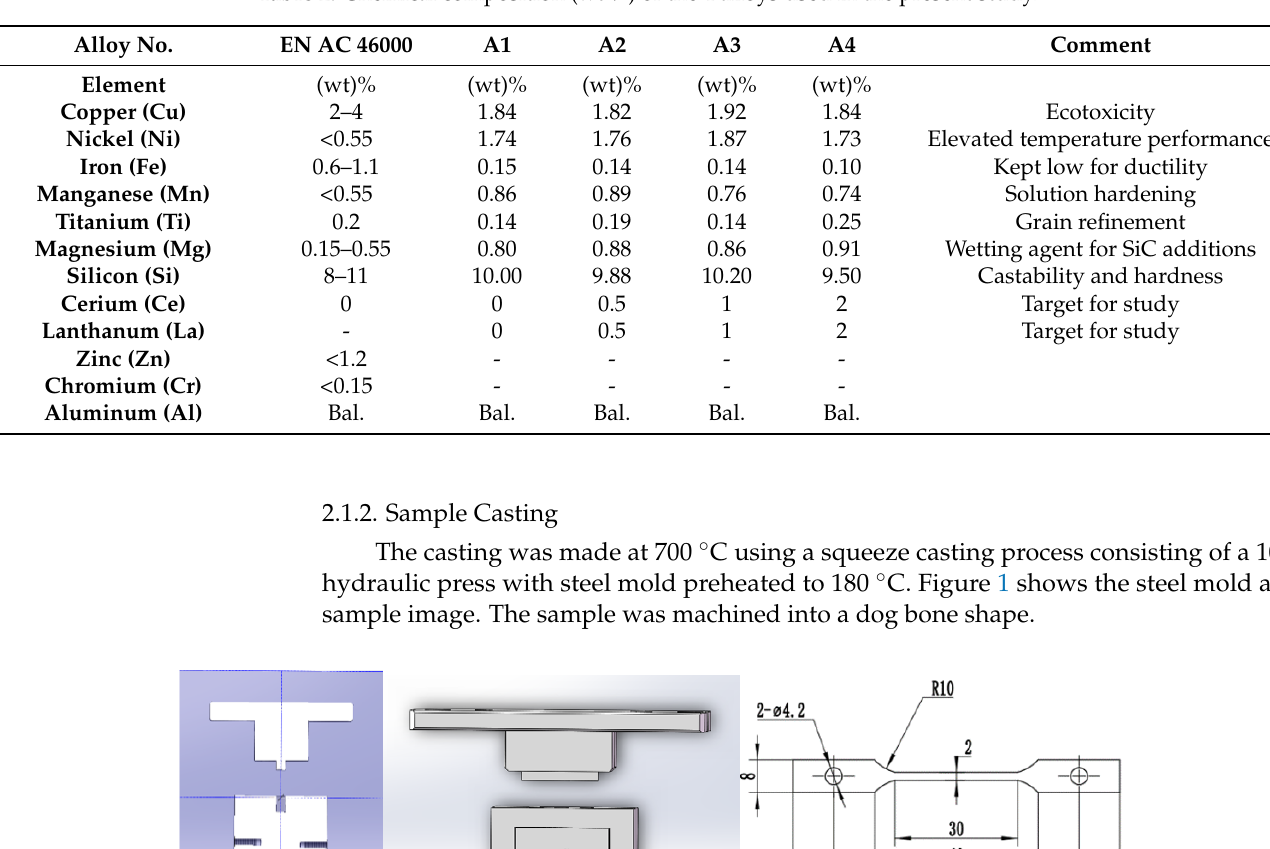
Table 2. Chemical composition (wt %) of the 4 alloys used in the present study.